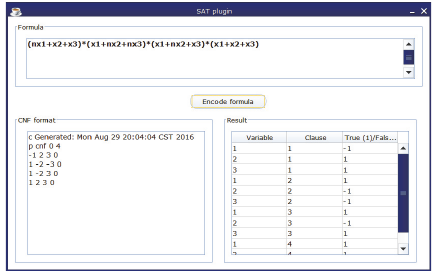
Figure 3: MeCoSim SAT plugin.